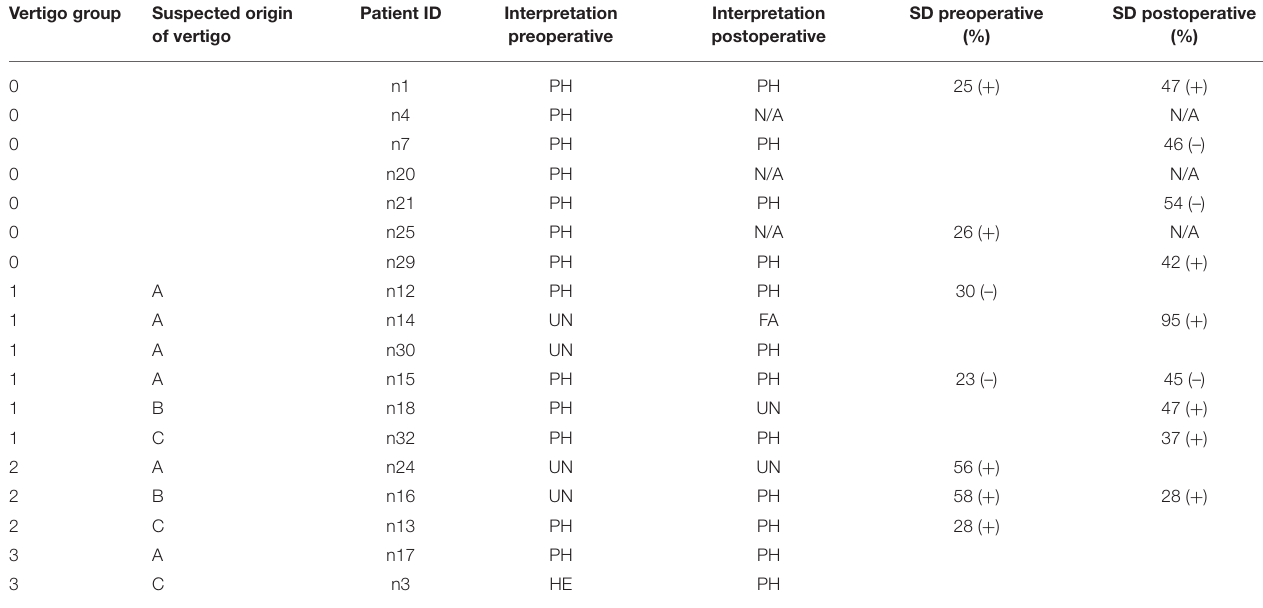
TABLE 6 | Caloric irrigation test result, slow phase velocity, and side difference (SD) conspicuous results only (for information on vertigo group and origin of vertigo, see Table 2 ). Vertigo group Suspected origin of vertigo